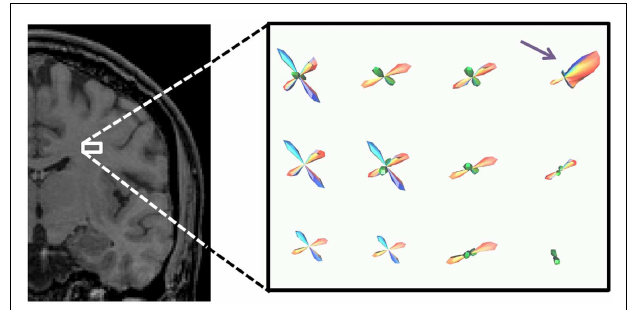
FIGURE 5 | PDF for the direction of propagation for tractography in a small ROI in the brain, shown by white box .The fiber geometry with the highest occurrence is shown in each voxel.The ROI is at the decussation of the thalamo-cortical tract (blue), projections of the corpus callosum (red), and superior longitudinal fasciculus (green).